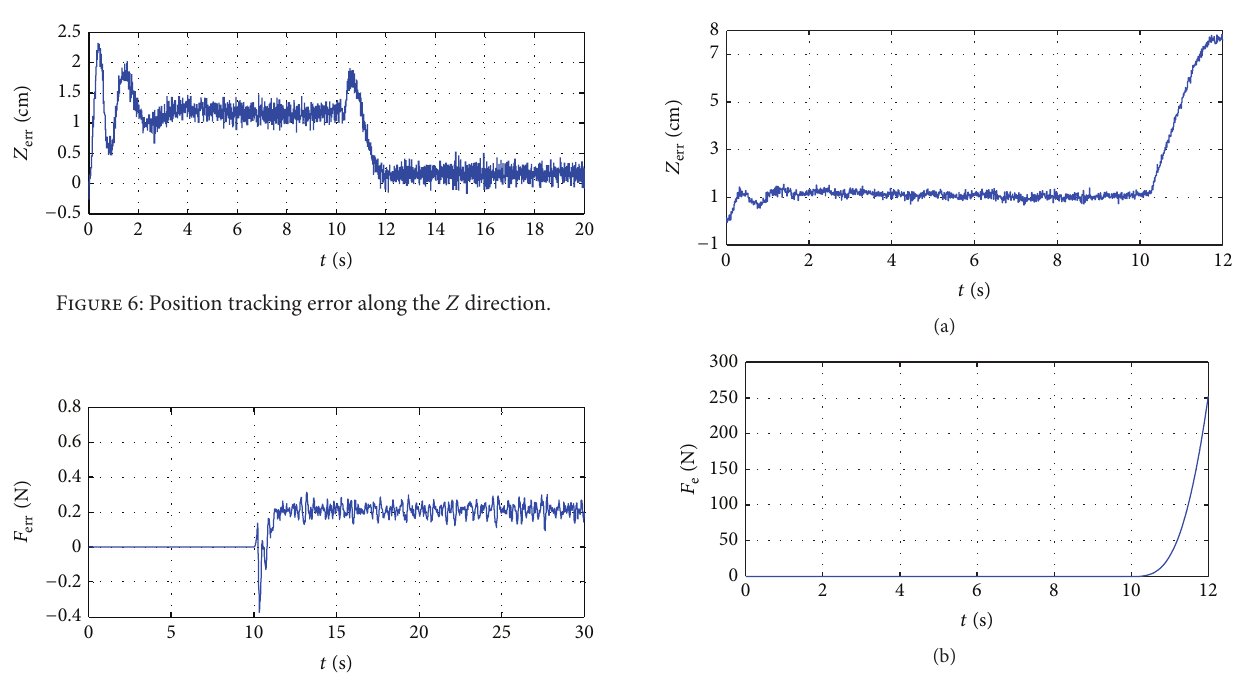
Figure 7: Force tracking error along the Z direction.